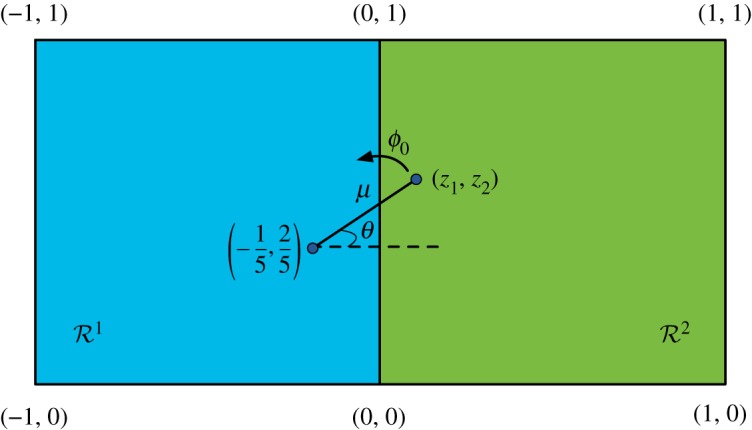
The action of f. The effect of the affine transformation f over an arbitrary vector z is to rotate it by an angle ϕ0 with respect to the point c^=(−15,25). (Online version in colour.)